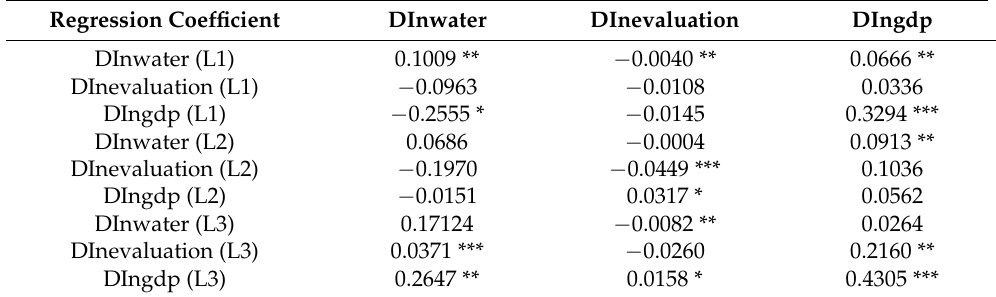
Table 5. Coefficients of panel moment estimation